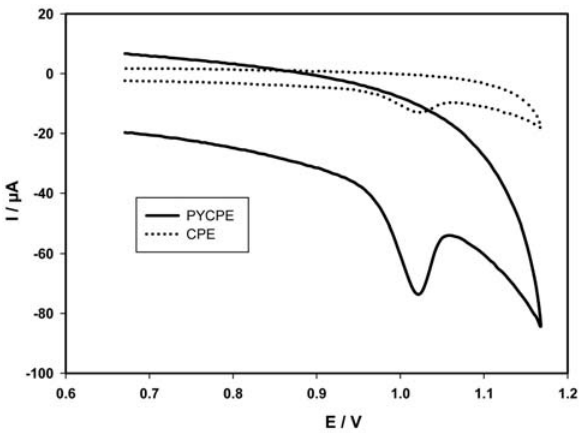
Figure 3: Cyclic voltammograms of 1.0 × 10 –3 mol/L MET solution in BR buffer (pH 2.0) at CPE and PYCPE. Scan rate of 100 mV/s.